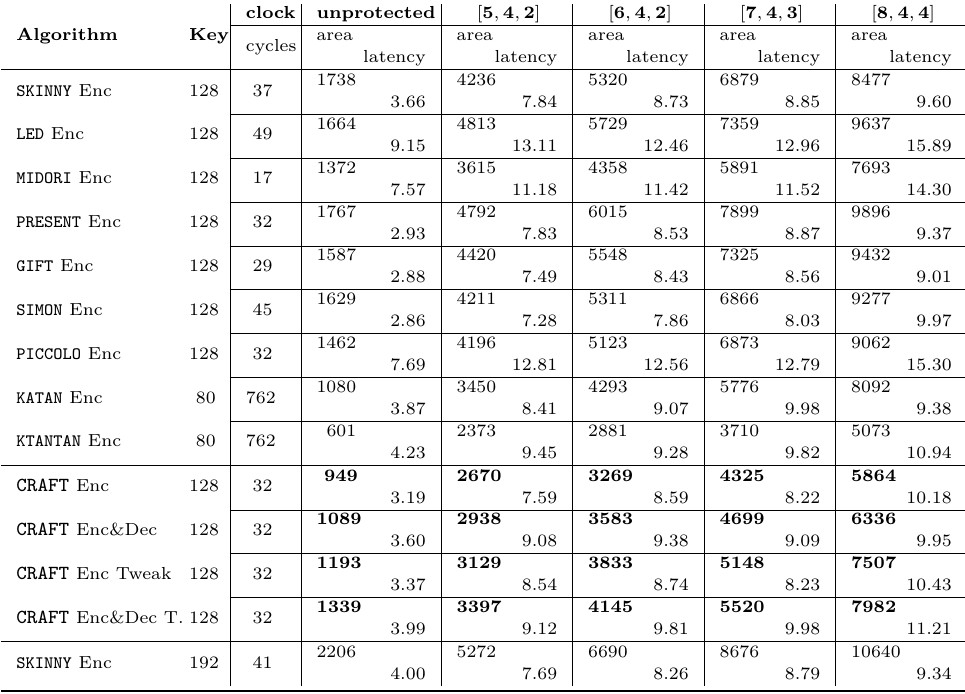
Table 8: Area (GE) and Latency (ns) comparison of round-based implementations consid- ering an M ∗ -bounded multivariate adversary with an [ n, k, d ] code, using IBM 130 nm t = d − 1 ASIC library, partially borrowed from [1].